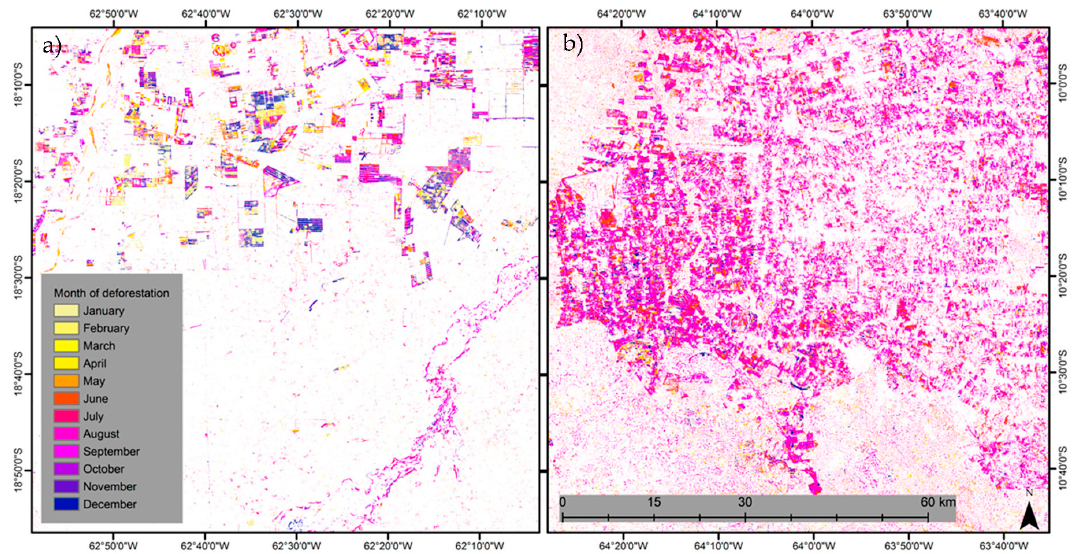
Figure 9. The month in which deforestation events detected from Landsat time series at Bolivian site ( a ) and Brazilian site ( b ) over the period of 2005–2014 occurred. Deforestation was detected as an extreme event in Landsat data cube with a reference period containing one year of data.